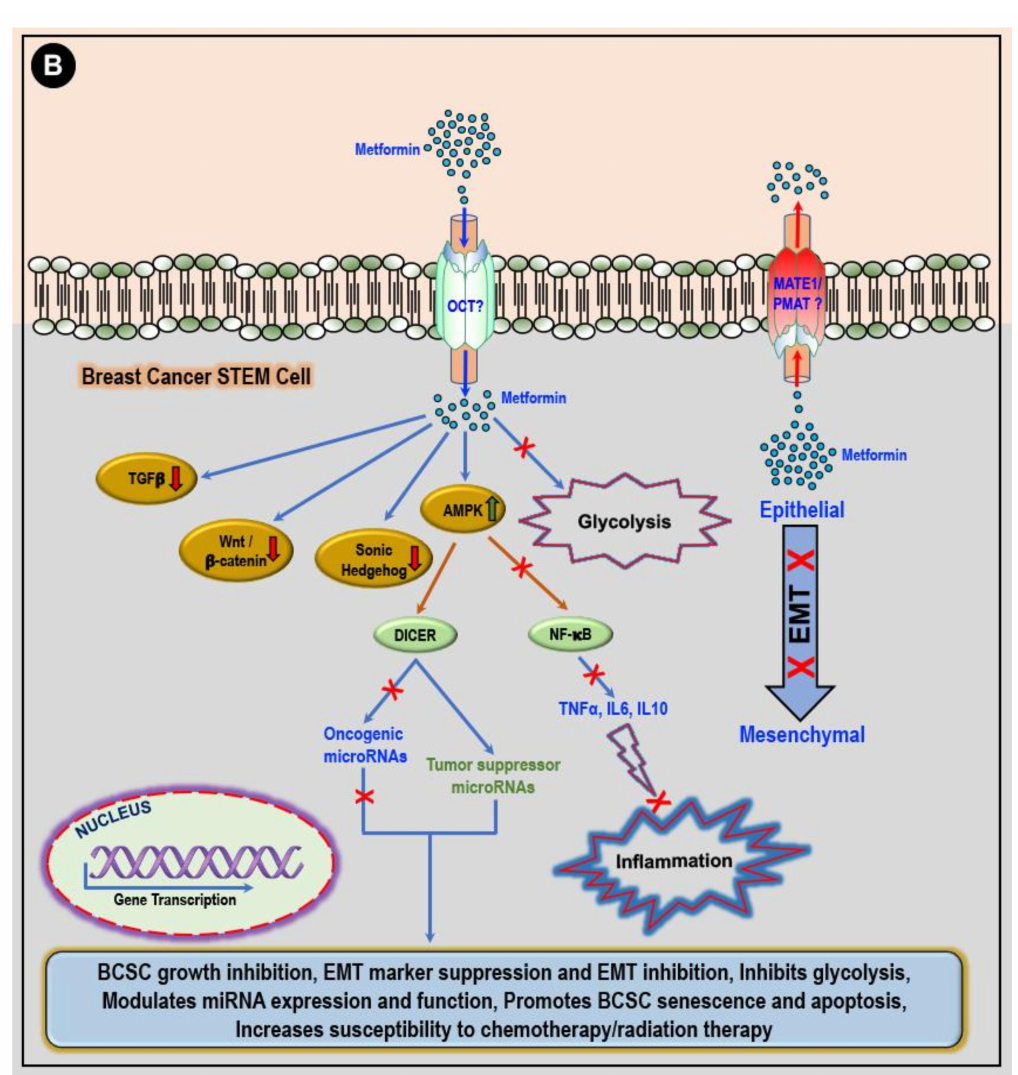
Figure 4. Known cellular anti-neoplastic and therapeutic resistance counteracting e ff ects of metformin: ( A ) in breast cancer cells (figure adapted and modified from our published article Samuel, SM. et al. 2019 in Biomolecules [51] and ( B ) in breast cancer stem cells (BCSCs) (figure adapted and modified